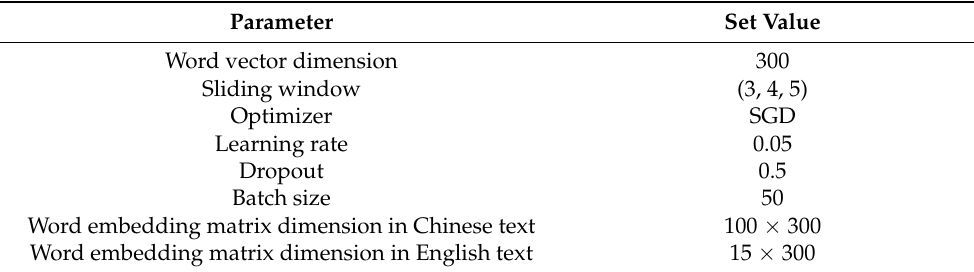
Table 2. LMT-CNN model parameter settings.